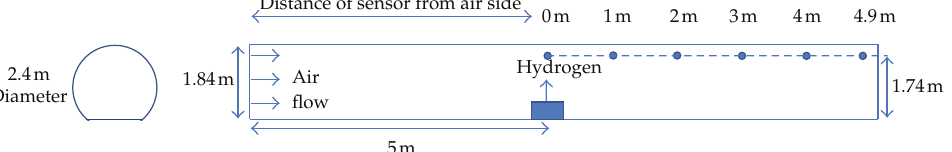
Figure 4: Schematic diagram of Model